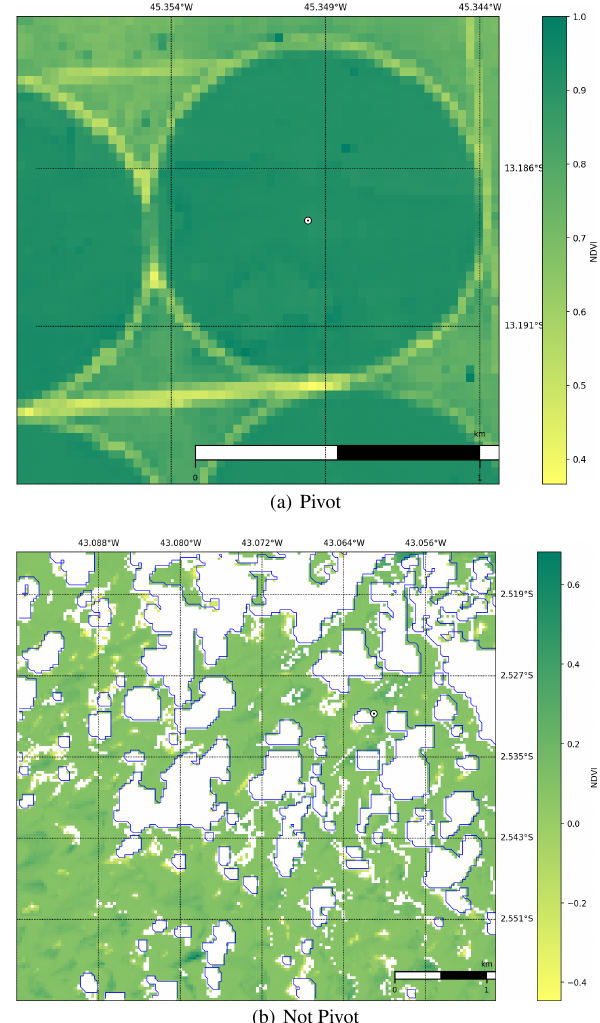
Figure 4. The centroids of candidate circles detected with CHT.